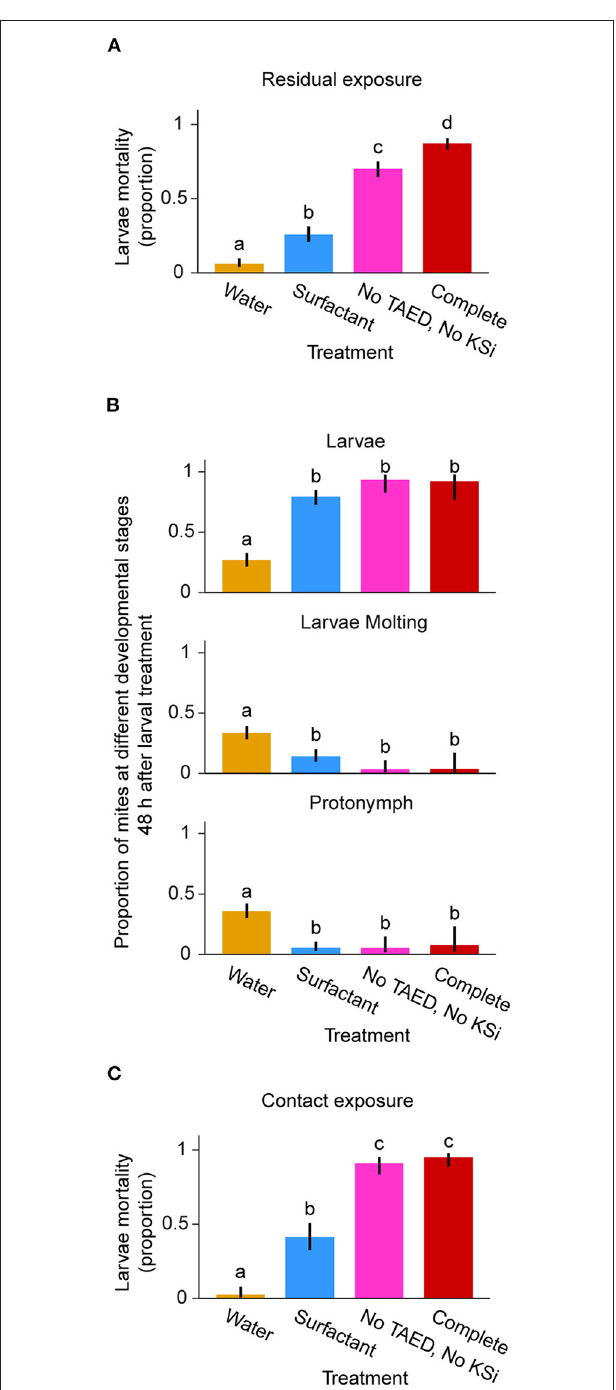
FIGURE 5 | Systemic effect of Neo-Boost. (A) Schematic of the experiment. (B) Representative pictures of experimental tomato leaves over the 3-day period. (C) Fecundity of 10 London mites per treatment after 3 days of feeding. Shown are means of egg counts/mite ± 95% confidence interval (CI). Letters represent differences between pairwise comparisons of means by Tukey’s HSD ( P < 0.05).